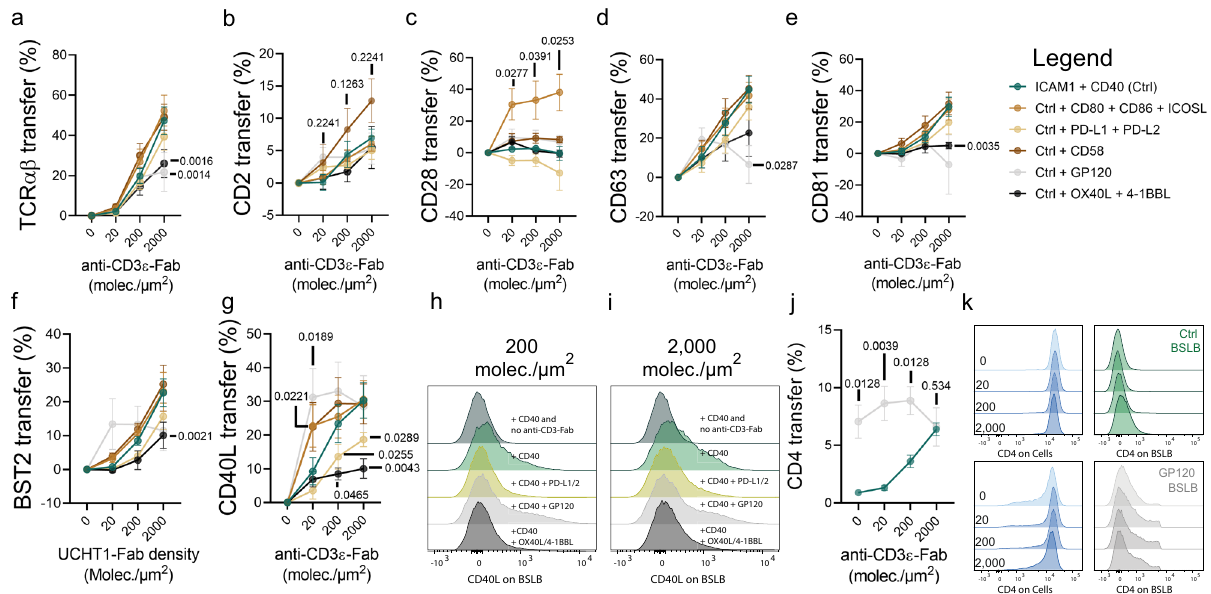
Fig. 4 Juxtacrine signals in fl uence the tSV output of TH synapses. a – k Normalized Synaptic Transfer (NST%) of various vesicular proteins in response to BSLBs presenting different juxtacrine signals. Please refer to Supplementary Fig. 1a for a representative gating strategy showing the identi fi cation of single BSLBs and T cells by fl ow cytometry. a TCR, b CD2, c CD28, d CD63, e CD81, f BST2, and g CD40L vesicular transfer to control BSLBs (dark green circles) and BSLBs presenting 100 molec./ µ m 2 of each juxtacrine signals CD80/CD86/ICOSL (brown circles), CD58 (dark brown circles), PD-L1/PD-L2 (light brown circles), HIV-1 gp120 (light gray circles), and OX40L/4-1BBL (black circles). h – i Representative half-overlaid histograms showing CD40L transfer to BSLB with various juxtacrine signals and in the presence of either 200 ( h ) or 2000 ( i ) molec./ µ m 2 of α -CD3 ε -Fab. j NST% of CD4 to control and HIV-1 gp120-presenting BSLBs. k Representative histograms showing the loss of CD4 on TH (bottom left panels and blue histograms). Data represents means ± SEM of n = 5 ( a – g , j ) biologically independent samples across three independent experiments. Normality was determined using Shapiro – Wilk test and statistical signi fi cance was determined by two-tailed Multiple t test with Holm – Š ídák correction ( α = 0.05) for the multiple comparisons of tSV transfer between control BSLBs and BSLBs decorated with different juxtacrine signals ( a – g , j ). Adjusted P values are shown next to each signi fi cant